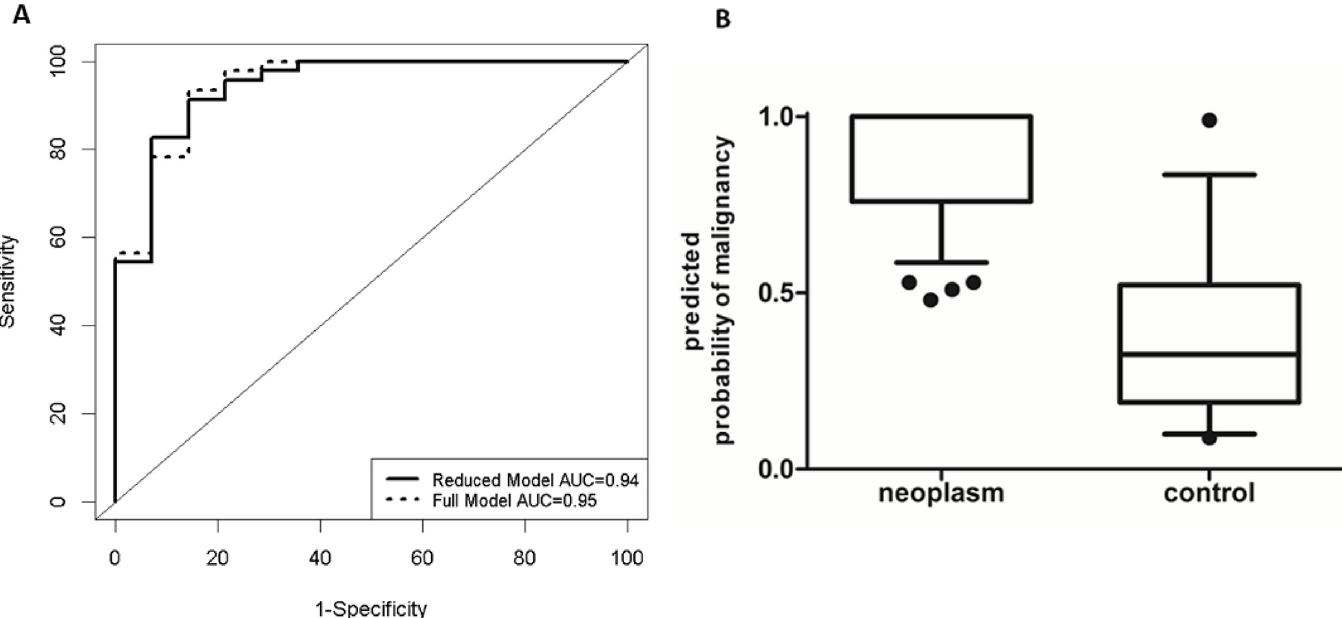
Fig 3. Receiver-operating-characteristics (ROC) curve and dot-plot showing the “ predicted probability of neoplasm ” . A. ROC curves computed from the full (dotted line) and the reduced (solid line) logistic regression models. The full model included 7 miRNAs (hsa-miR-103a-3p, hsa-miR-211, hsa-miR-296- 5p, hsa-miR-425-5p, hsa-miR-1233, hsa-miR-1267 and hsa-miR-1825). It yielded an AUC of 0.95 (95% CI: 0.88 – 1.00), a sensitivity of 93% and a specificity of 86%. The reduced final model included hsa-miR-2 and hsa-miR-1233, which in combination provided satisfactory prediction while being parsimonious. The AUC was 0.94 (95% CI: 0.87 – 1.00), the specificity was 86% and sensitivity was 91%. B. Predicted probability of neoplasm was based on validation data of 2 validated miRNAs (hsa-miR-211 and hsa-miR-1233). Whole saliva samples from patients with a parotid gland neoplasm had a high “ predicted probability of neoplasm ” , while whole saliva samples from controls with non-neoplastic parotid glands in average had a lower “ predicted probability of neoplasm ” . Lower line represents minimum “ predicted probability of neoplasm ” , middle line represents the mean “ predicted probability of neoplasm ” , and the upper line represents the maximum “ predicted probability of neoplasm ”